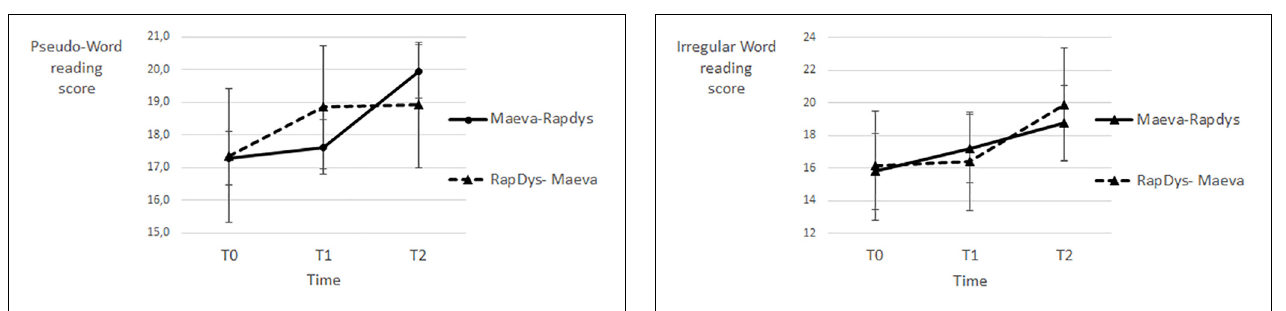
FIGURE 6 | Pseudo-word word reading scores for each time period and each presentation order.